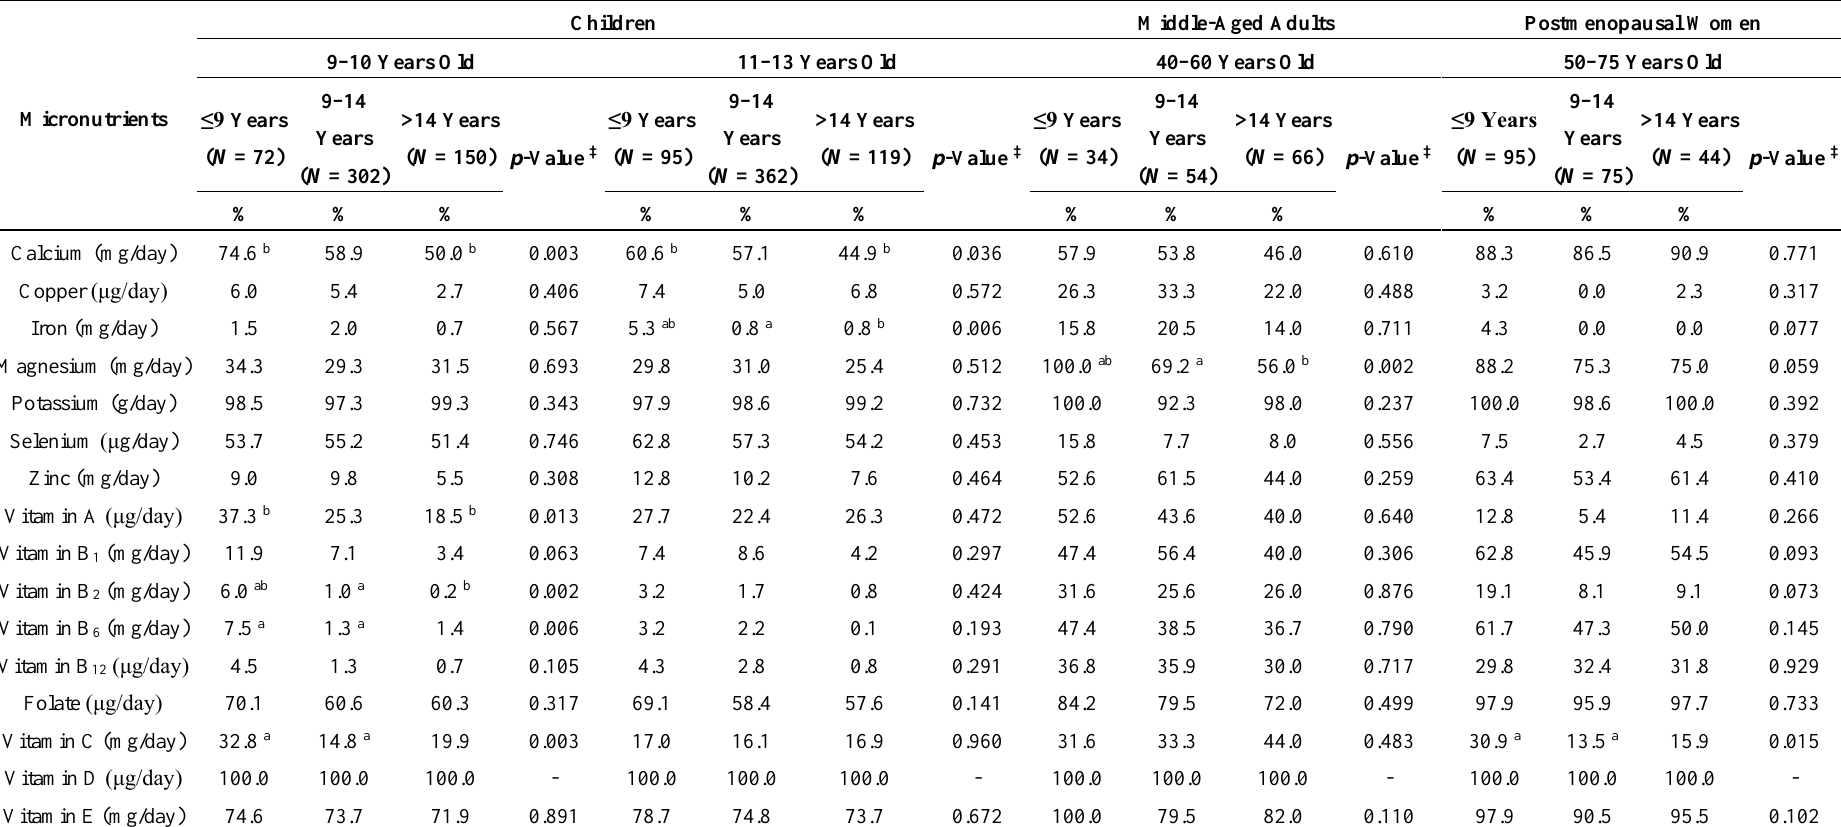
Table 5. Percentages of children, middle-aged adults and postmenopausal women in Greece with usual dietary intakes below EAR, presented by age group and educational (parental in the case of children)